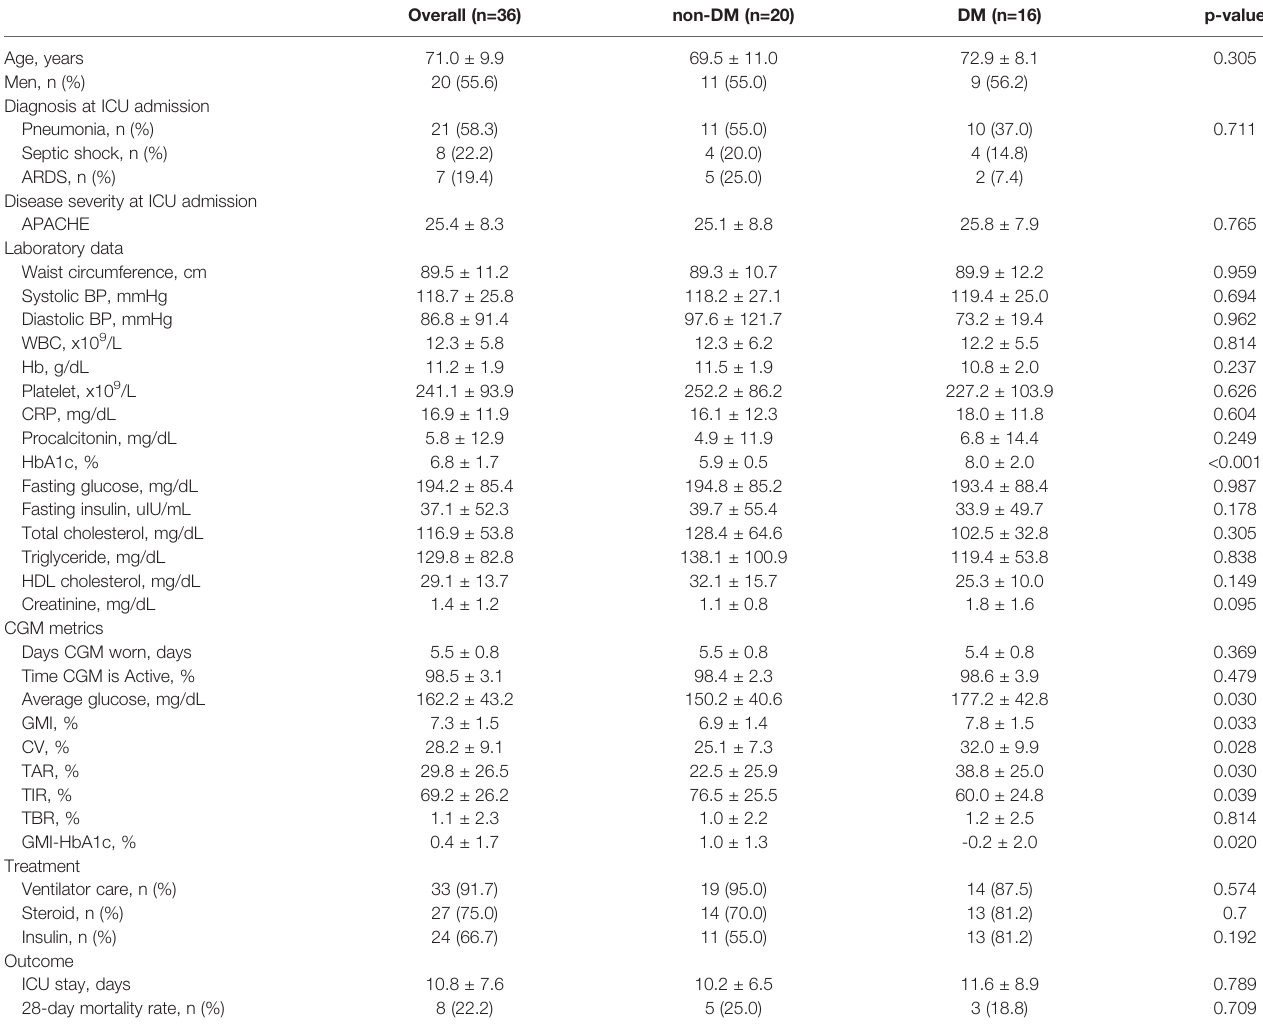
TABLE 1 | Comparison of baseline characteristics between patients with and without